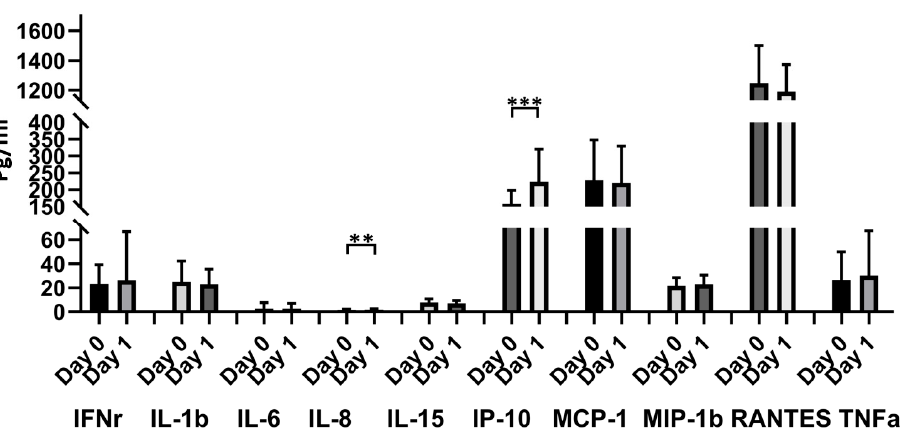
Figure 5. Blood cytokine expressions in the 48 donors with ChAdOx1 nCoV-19 vaccination at different time points. Comparison of 10 cytokines (IFNr, IL-1b, IL-6, IL-8, IL-15, IP-10, MCP-1, MIP-1b, and RANTE) between day 0 and day 1. ** p < 0.01, *** p < 0.001